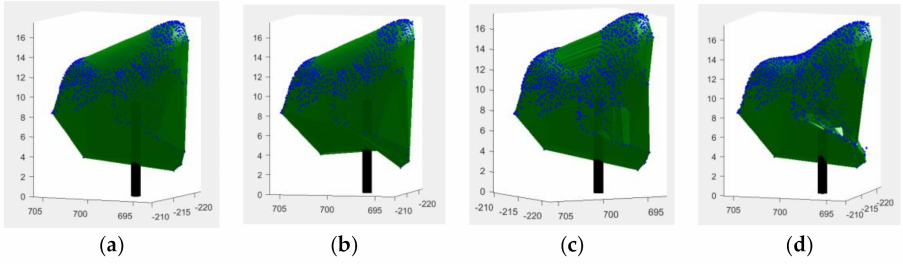
Figure 15. Surface reconstruction results on photogrammetric point clouds that have been trans- formed by spherical harmonics fitting using ( a ) convex hull, ( b ) concave hull, ( c ) alpha shape, and ( d ) robust crust methods.